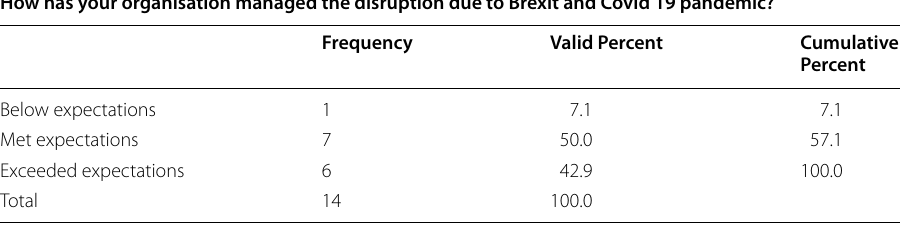
Table 8 Response to organisational management despite Brexit and Covid